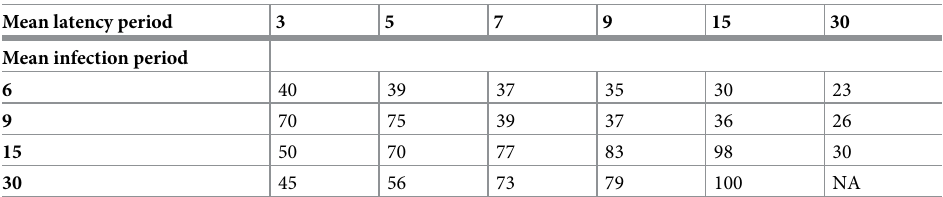
Table 2. Time lag between D ratio and number of daily active cases (Days).